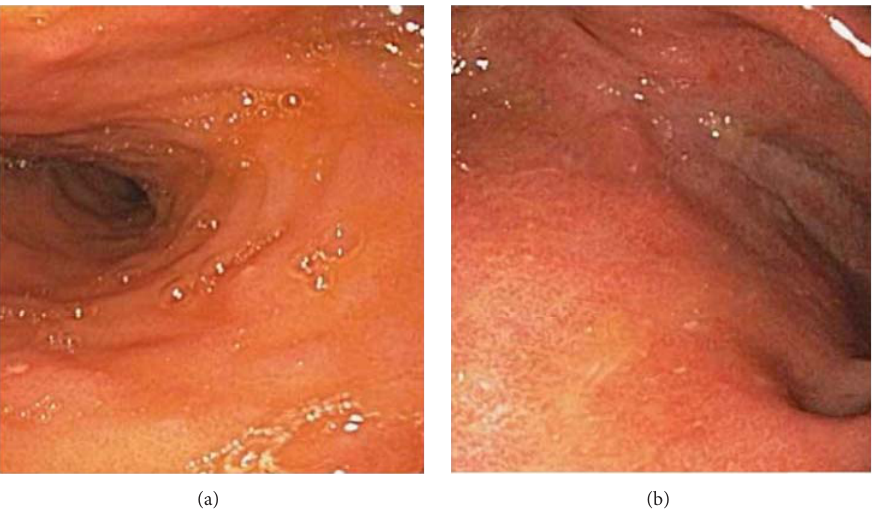
Figure 2: (a) Prepouch ileum. (b) Distal